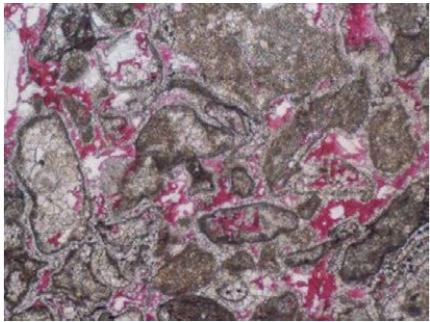
Figure 2: Silty dolarenite, S2, 2355.04 ∼ 2355.65 m, T 1 j 2 .